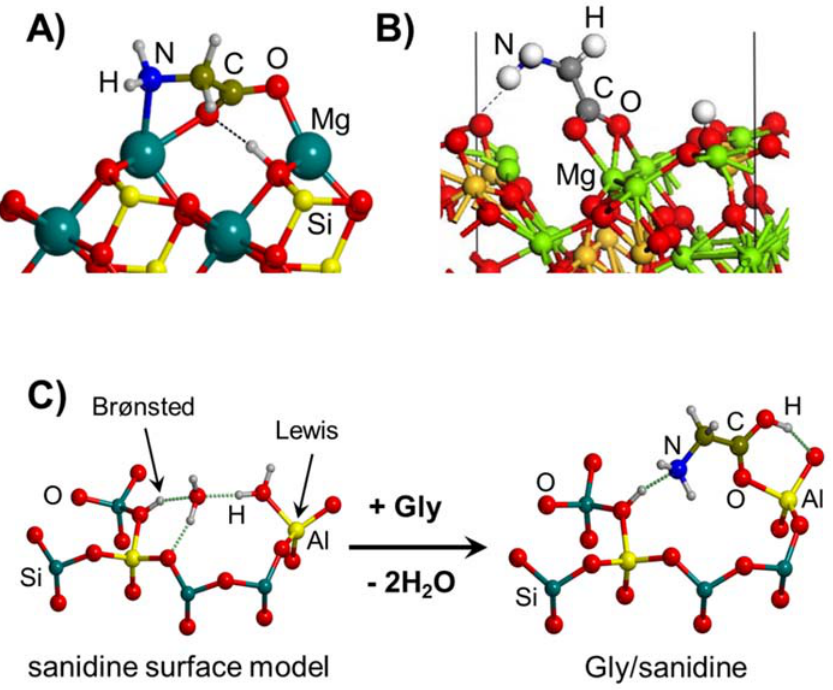
Figure 5. ( A , B ) Interaction of Gly with a silicate surface adopting different adsorption modes (adapted from Refs. [154,155]). ( C ) Sanidine surface model containing an acidic Lewis and Bronsted site, and the interaction of Gly with these surface sites (adapted from Refs. [158,159]).